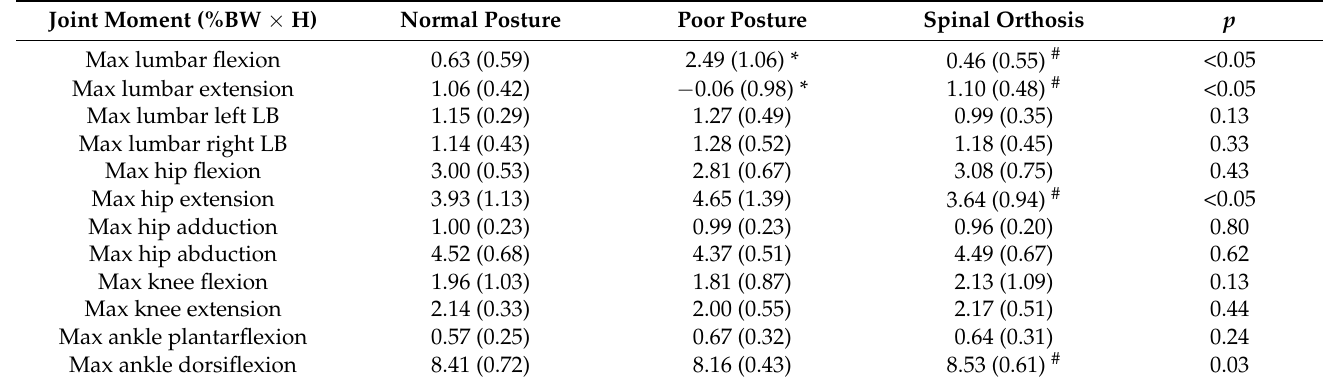
Figure 5. Joint moments (mean and standard deviation) during the gait cycle when walking in normal posture, poor posture, and spinal orthosis. Table 2. Statistical analysis of the maximum joint moments during the gait cycle (mean ±